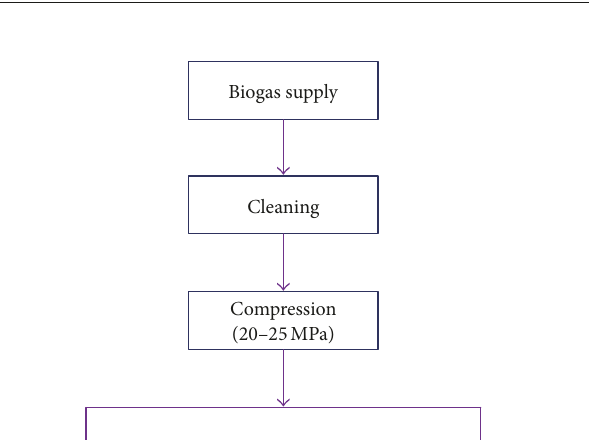
Figure2:Biogasgenerationpotentialfromdifferentbiomasswastes.